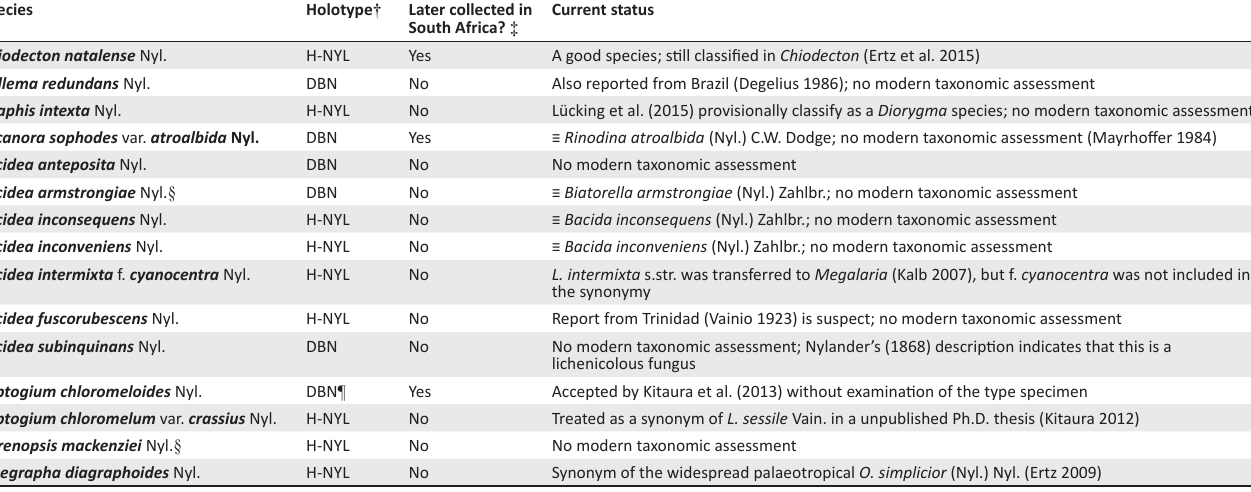
TABLE 1: New species described by Nylander (1868).